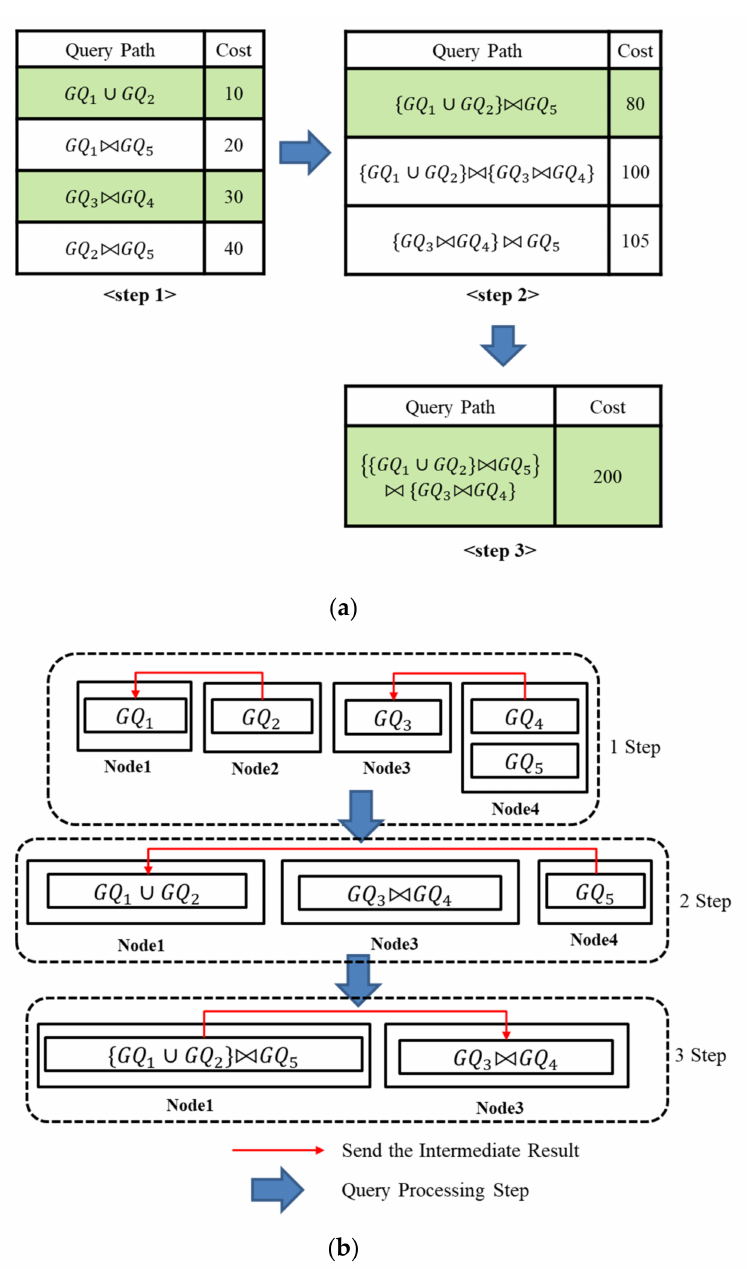
Figure 6. ETE algorithm operation: ( a ) step to select the optimal query path; ( b ) query processing order for each